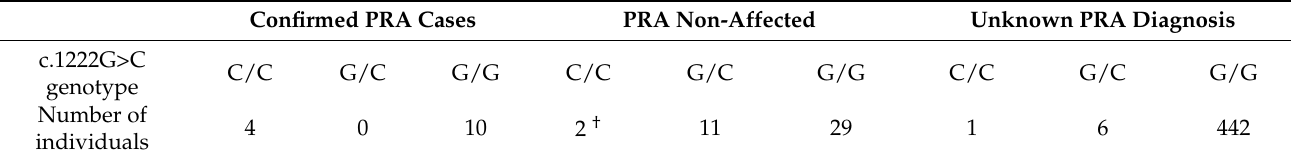
Table 2. Genotype distribution of the BBS2 c.1222G>C SNV in SS confirmed PRA cases and non-affected controls or SS with an unknown PRA